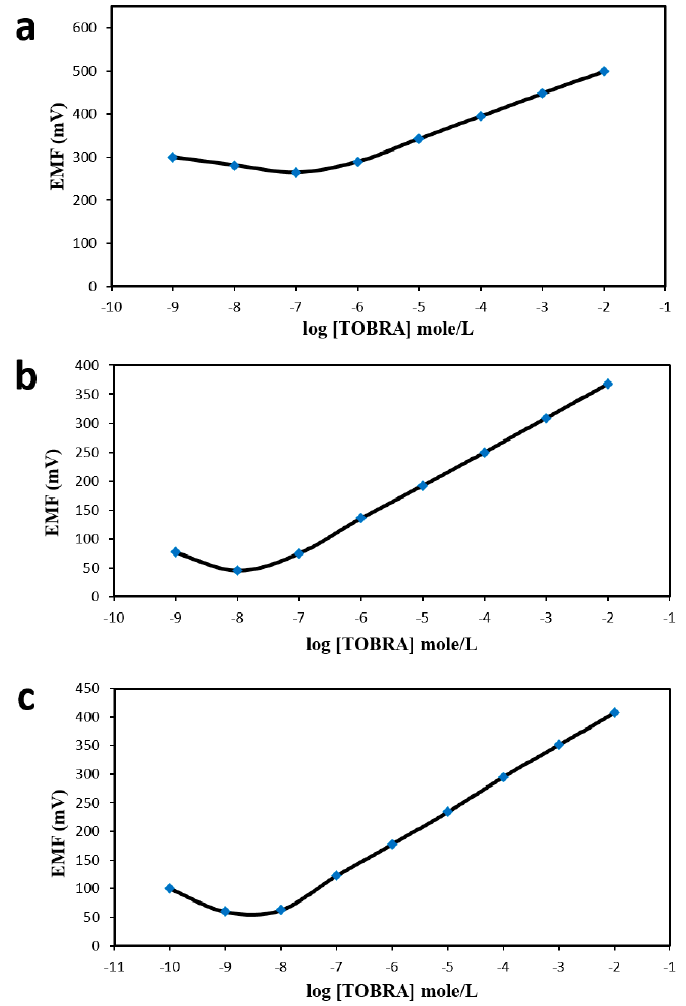
Figure 4. Calibration curves of ( a ) Bare-Carbon paste electrode, ( b ) AgNp-modified Carbon paste electrode, and ( c ) C-dots-modified Carbon paste electrode. Table 1. Performance characteristics of the three fabricated electrodes.